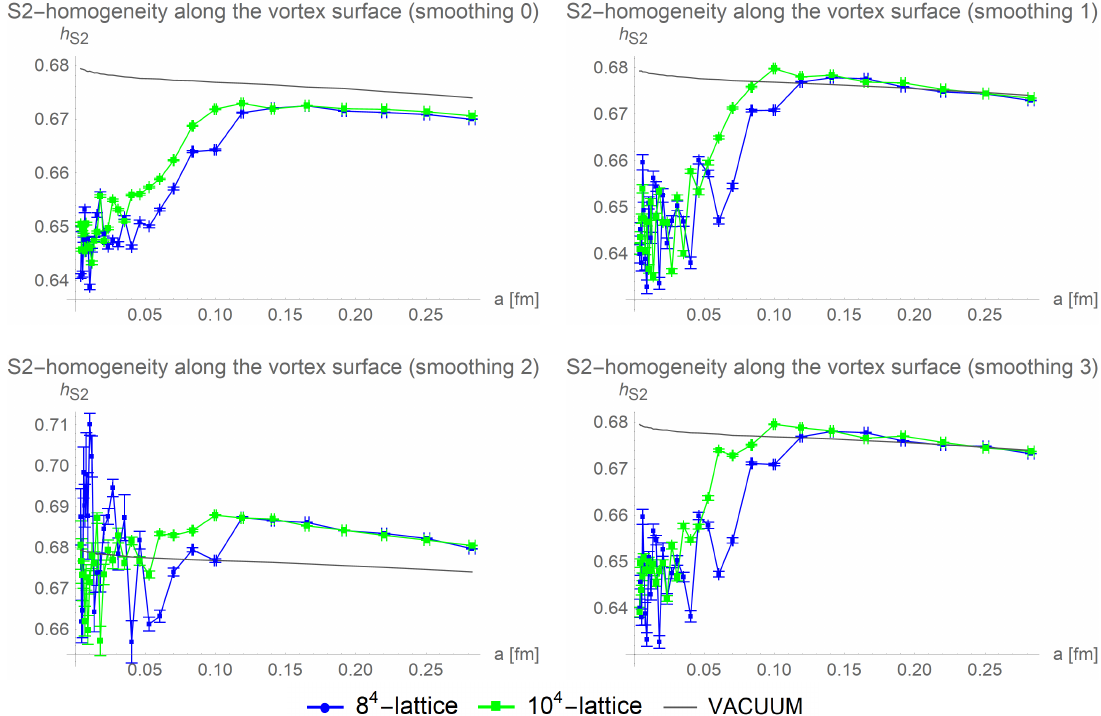
Figure 12. Averaged over 100 configurations, the S2-homogeneity along the vortex surface is compared for different lattice sizes and smoothing procedures after two cooling steps. The vortex is no longer distinguishable from the vacuum for smoothing 1 and smoothing 3.